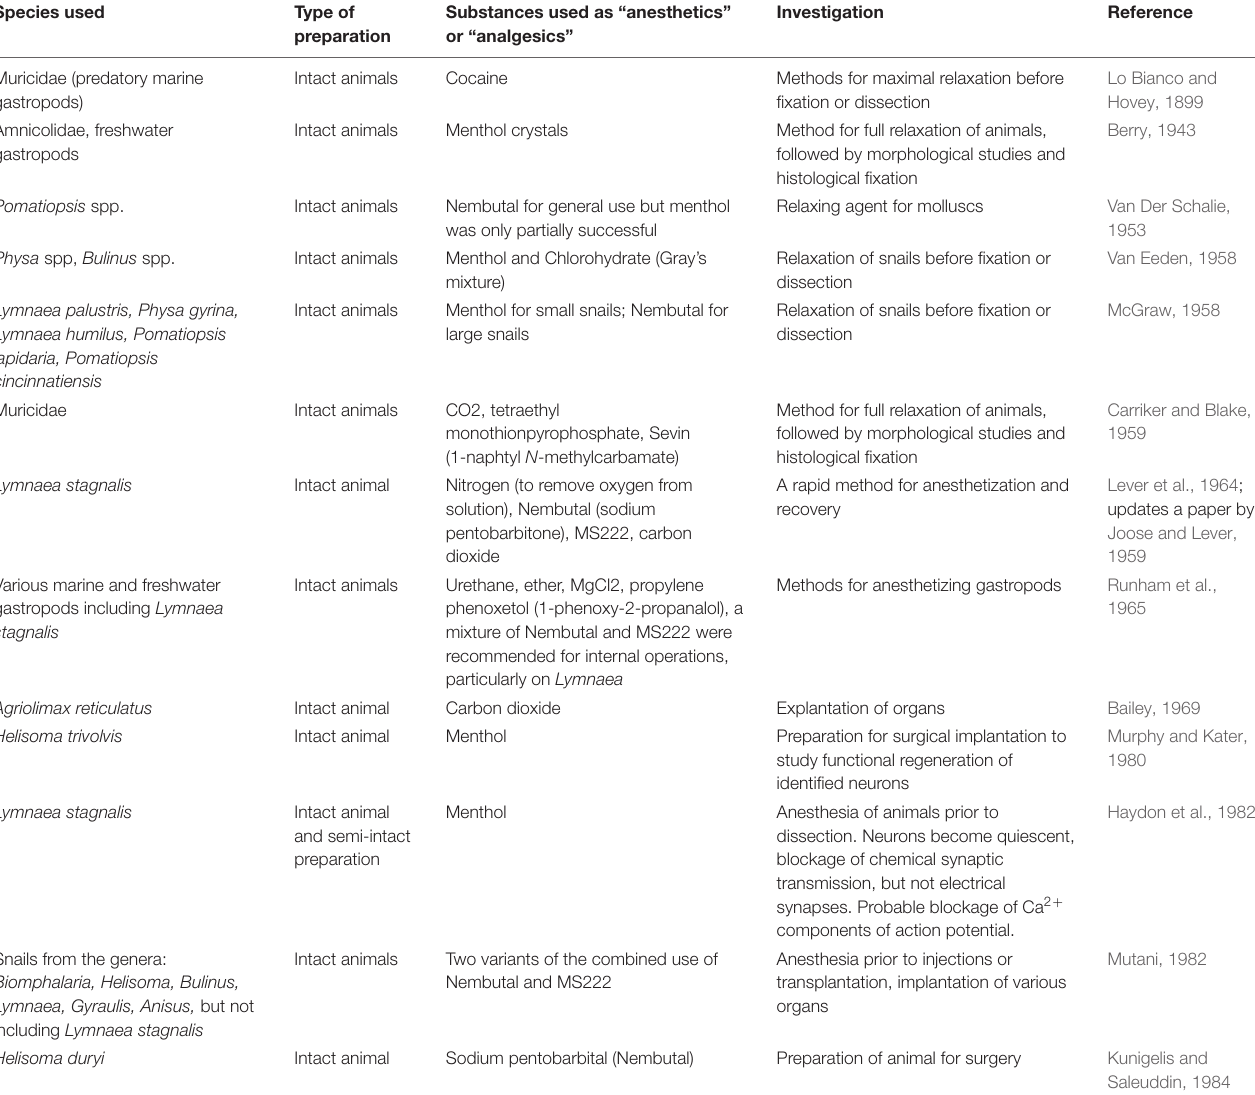
TABLE 1 | A selection of substances used to relax gastropod species prior to surgery or